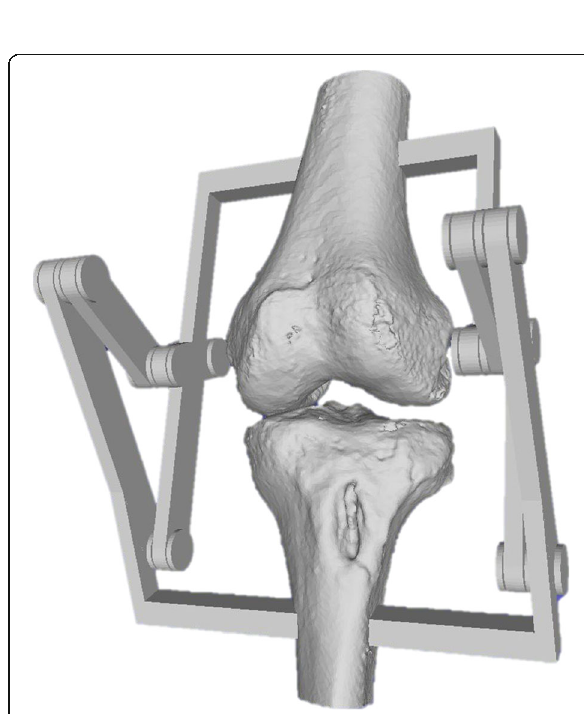
Fig. 6 3D knee model with the four-bar mechanism constructed in 3D for a single piece printing